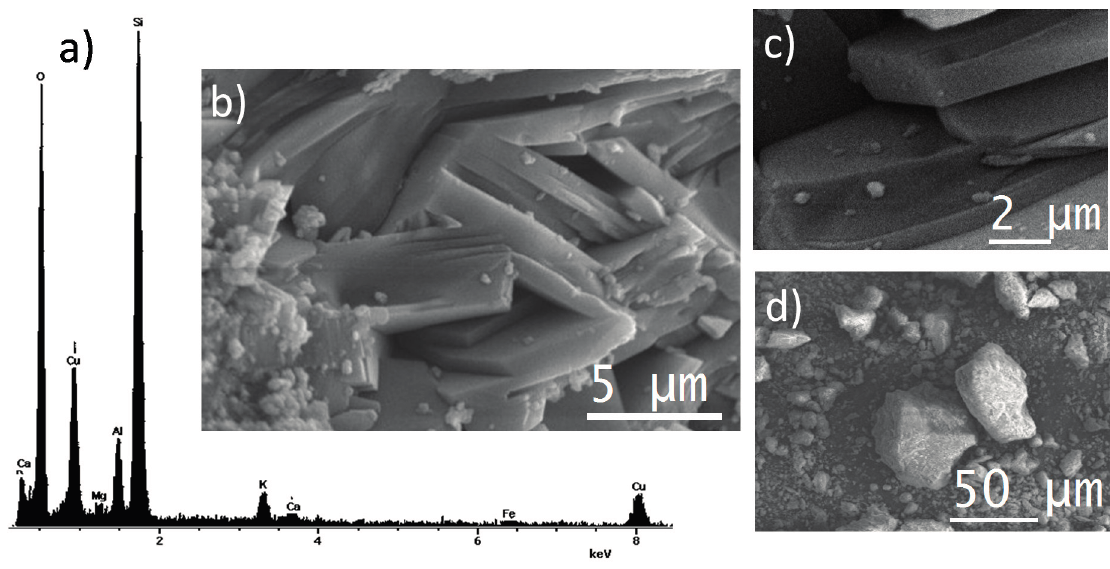
Figure 1. ( a ) EDS chemical analysis of the natural zeolite; ( b – d ) Bright-field SEM images corresponding to the clinoptilolite, mordenite, and feldspar phases,